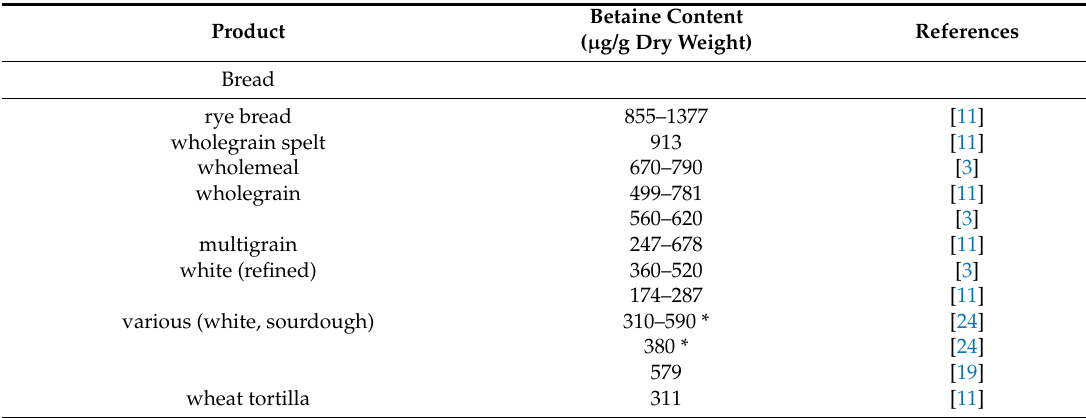
Table 2. Betaine content in various grain-based